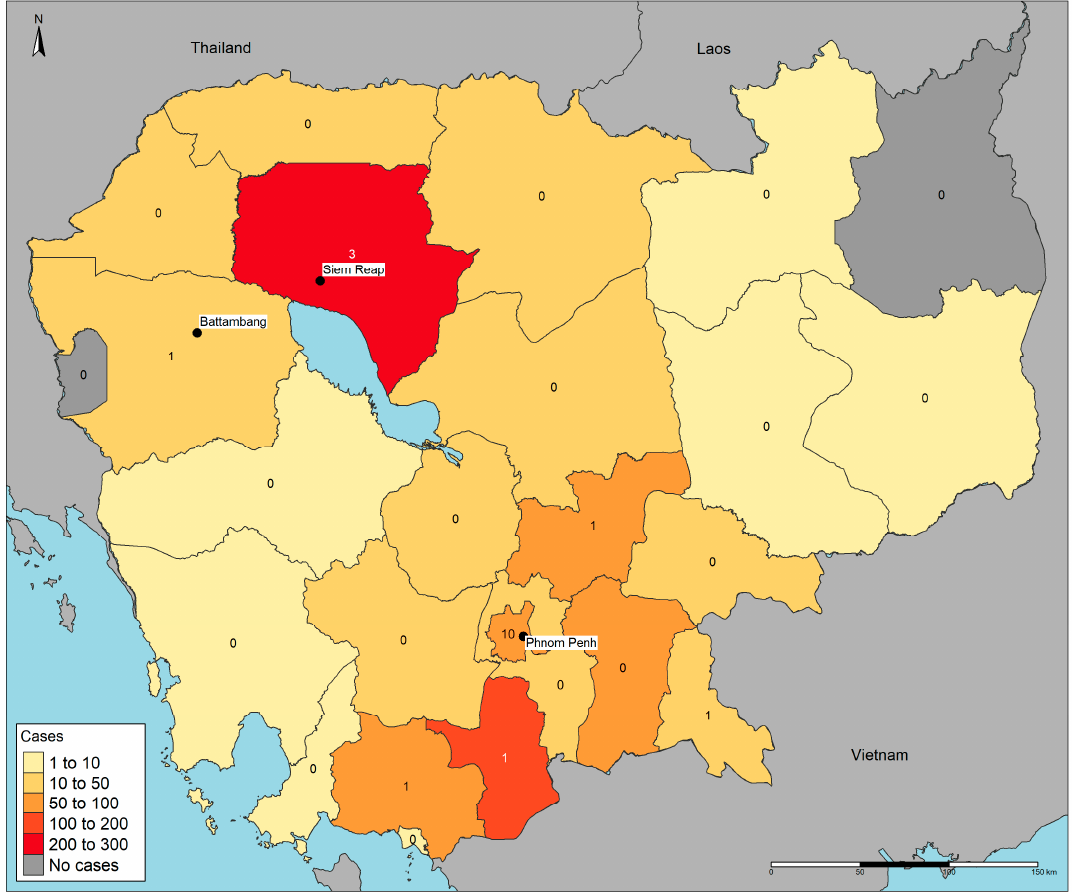
Figure 2. Geographic distribution of melioidosis cases in Cambodia, October 2005–September 2017.